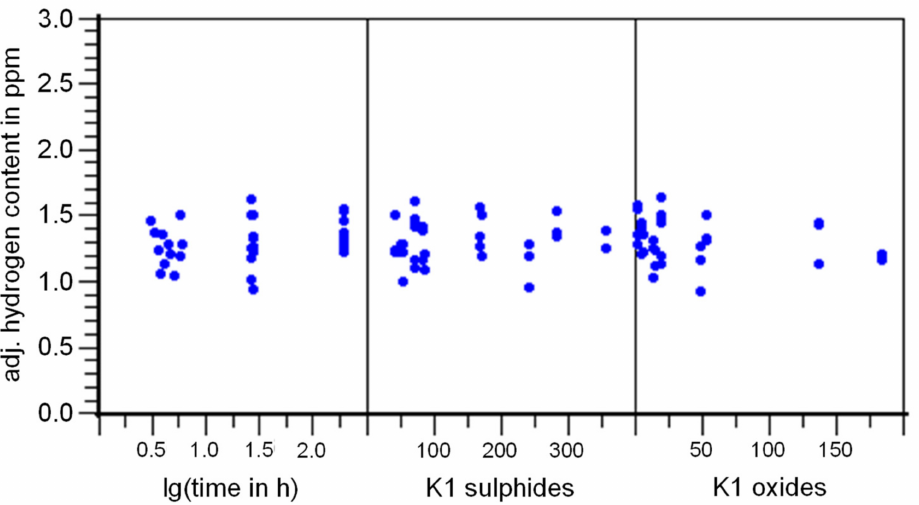
Figure 12. Effects of the factors logarithmic storage time, cumulative characteristic value for sulphides (K1 sulphides) and cumulative characteristic value for oxides (K1 oxides) on the total hydrogen content of the quenched samples (adj. R 2 = 0.93, F = 28).